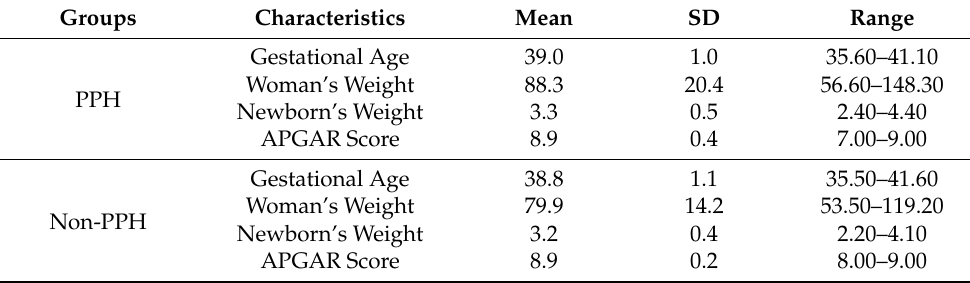
Table 2. Maternal and Infant Medical Data for Women with/without PPH.